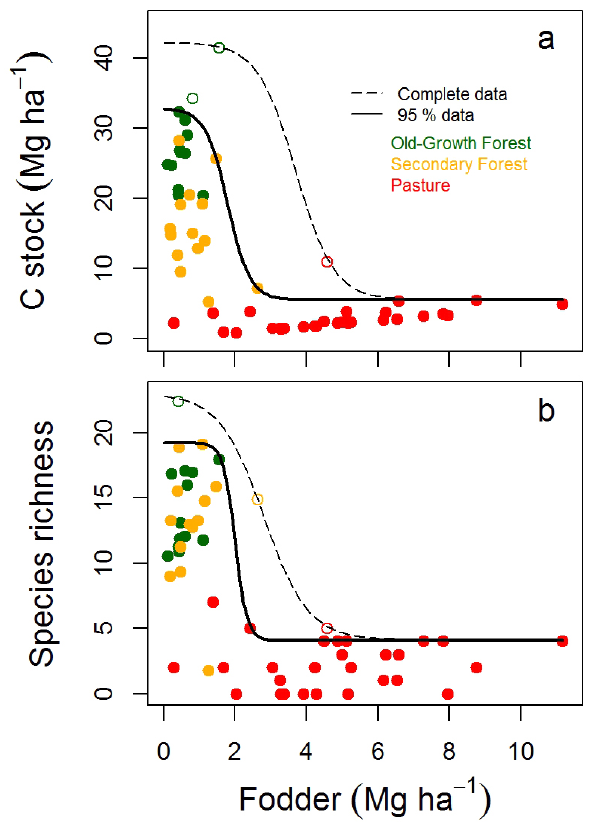
Fig. 2 . Plot level efficiency frontiers between (a) fodder and C stock in the above-ground living biomass of trees, and (b) fodder and rarified tree species richness for tropical dry forests and pasture sites within and adjacent to the Chamela-Cuixmala Biosphere Reserve. The fitted efficiency frontiers derived when using the complete dataset are indicated by discontinuous lines, and the efficiency frontier derived when excluding the most extreme 5% of C stock or species richness data (hollow points) are indicated by continuous lines.